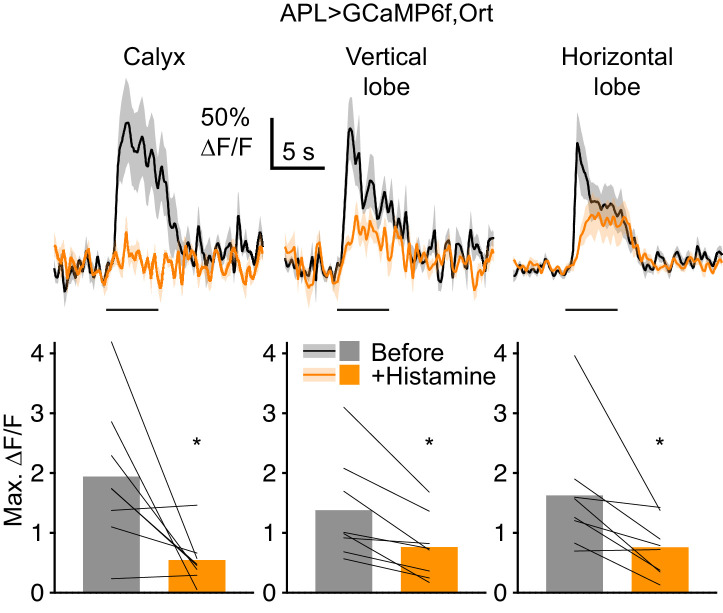
When APL expresses Ort, histamine reduces odor-evoked Ca2+ influx in APL.Traces (mean ± SEM shading) show APL responses to isoamyl acetate (horizontal bars) before (black) and after (orange) bath-applying 2 mM histamine, in flies expressing GCaMP6f and the histamine-gated Cl- channel Ort in APL, driven by NP2631-GAL4/GH146-FLP. Graphs show maximum ∆F/F (same colors as traces). Bars show mean, thin lines show paired data (same hemisphere before and after histamine). *p<0.05, paired t-test or Wilcoxon test. The residual GCaMP6f response most likely reflects calcium influx through nAChRs (cholinergic input to APL when APL is blocked by histamine would be much higher due to increased KC activity: Apostolopoulou and Lin, 2020). Apparent differences in effect size in different parts of APL might reflect differential localization of Ort or differential penetration of histamine into the brain. Note that when APL does not express Ort, histamine has no effect on Kenyon cell odor responses (Apostolopoulou and Lin, 2020) and thus is unlikely to non-specifically affect APL odor responses.Figure 2—figure supplement 1—source data 1.Source data for Figure 2—figure supplement 1.